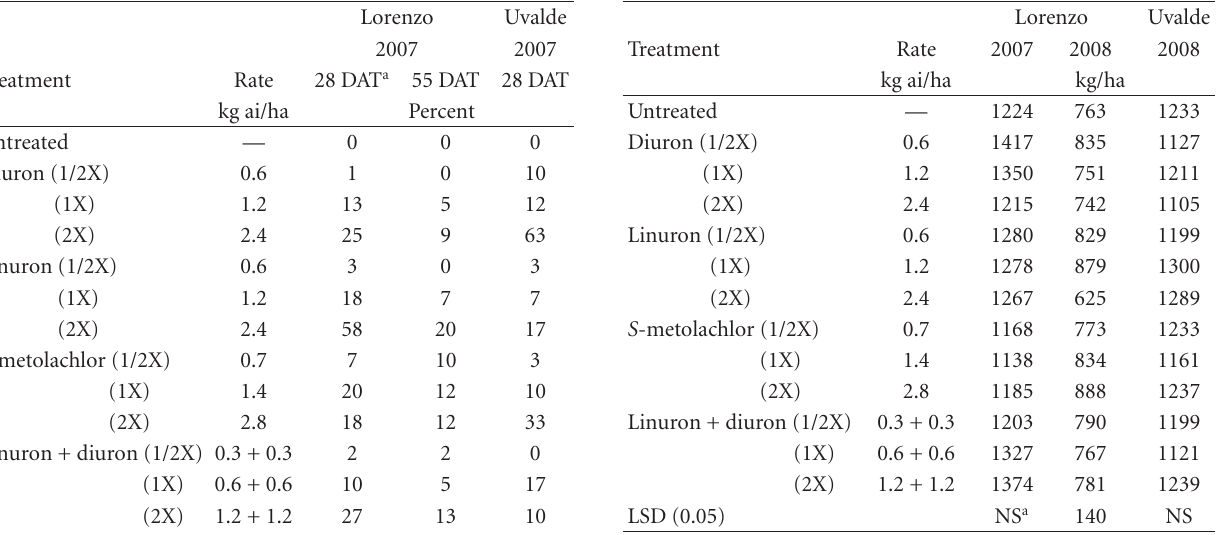
Table 5: Sesame yield response to preemergence herbicides at two locations in